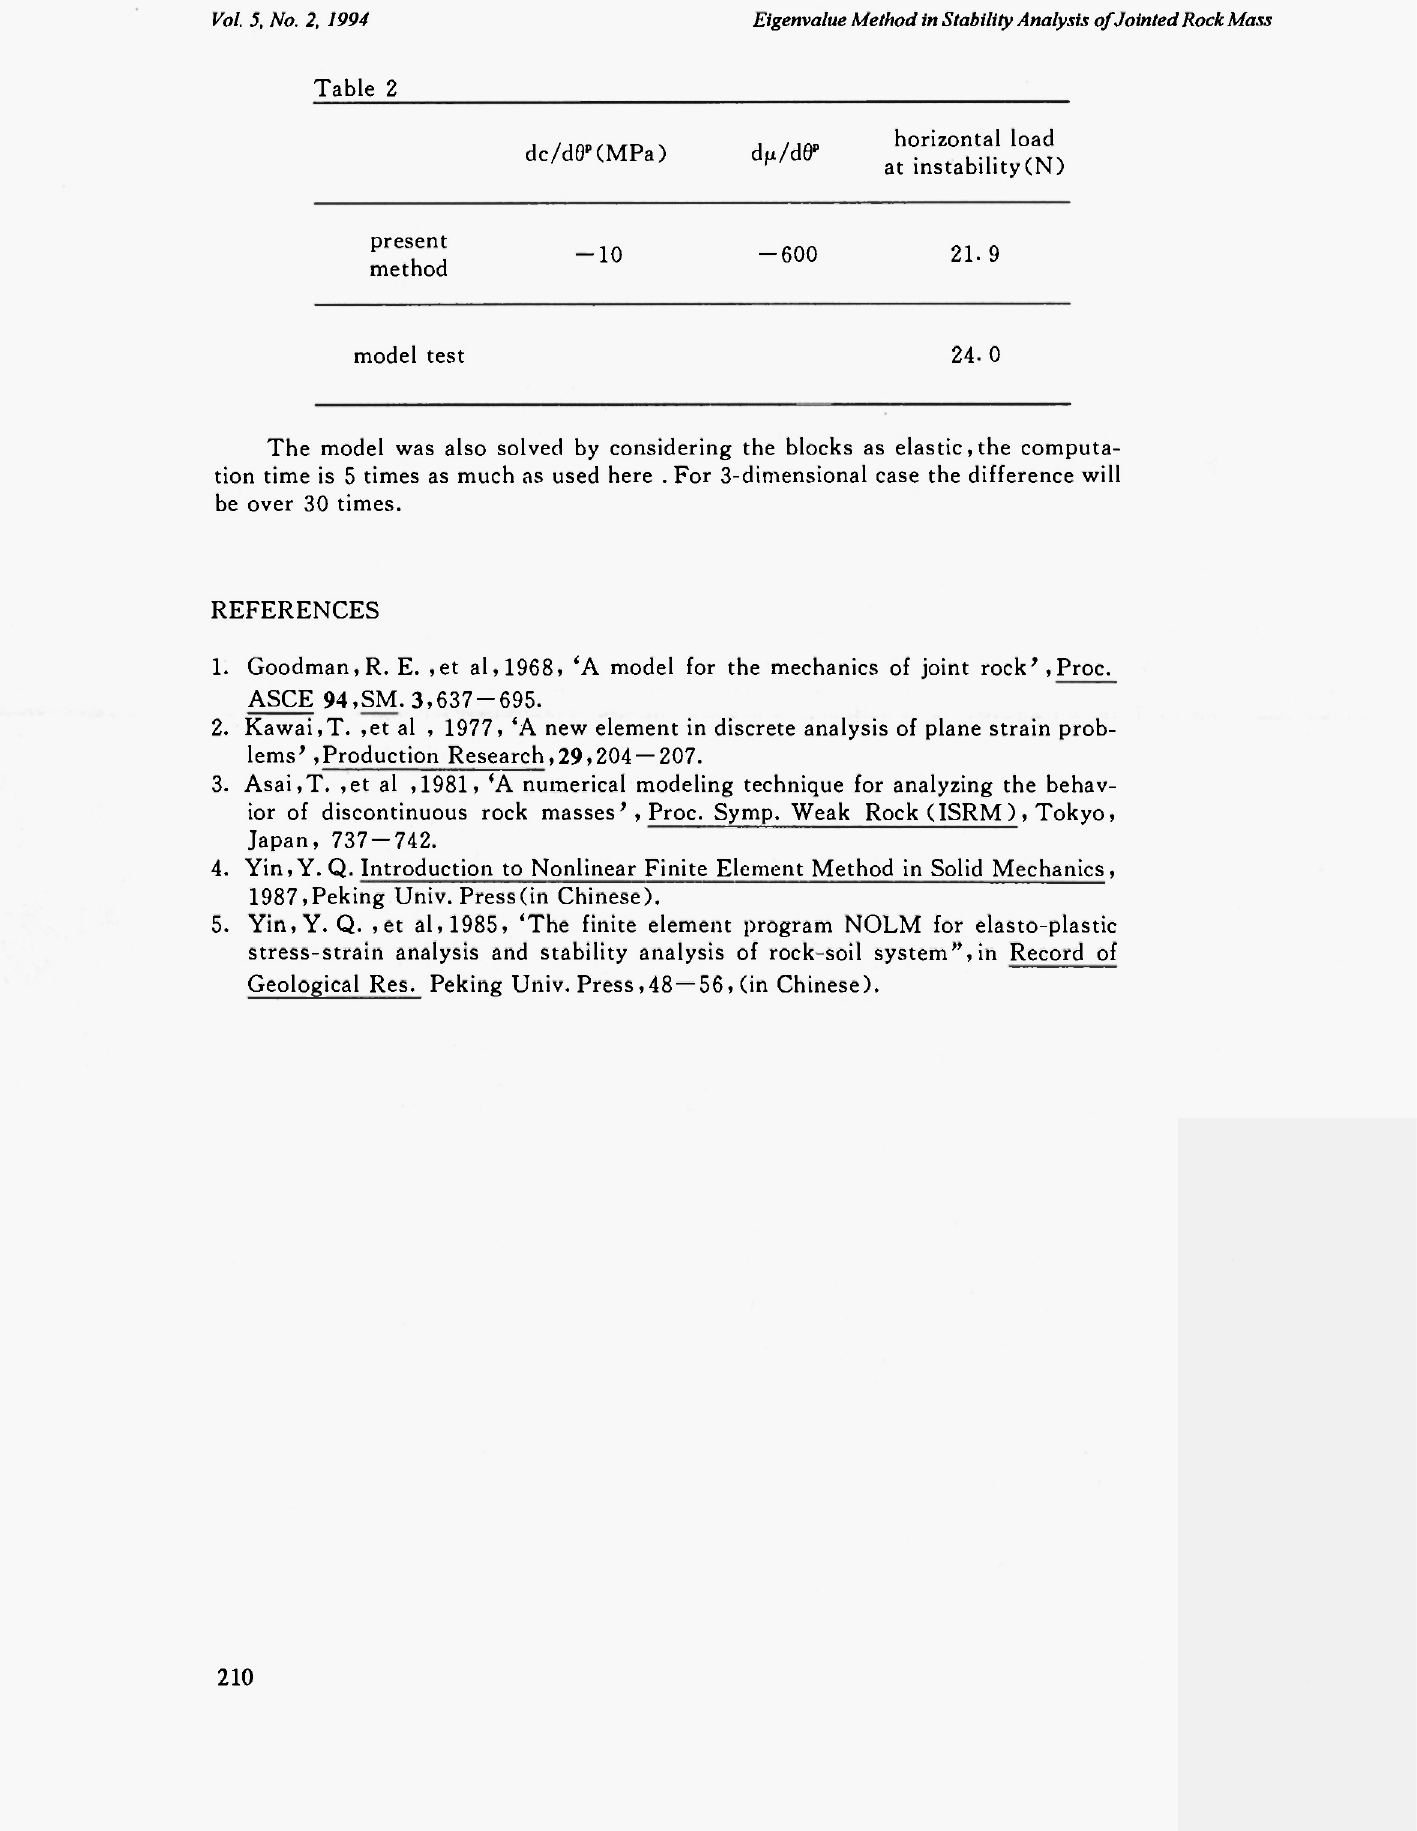
Table 2 dc/dO p (MPa) dμ/dθ p present - 10 21. 9 method